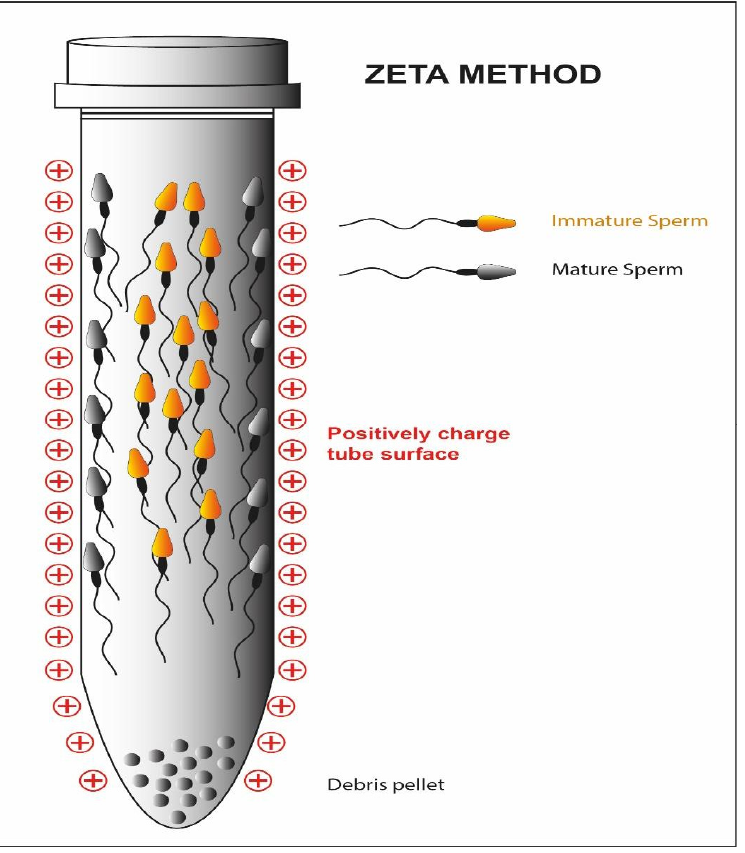
Figure 8. Schematic representation of the Zeta method. The high negative charge of the mature sperm cell membrane reacts with the positive charge of the tube while the immature fraction is detached form the tube.